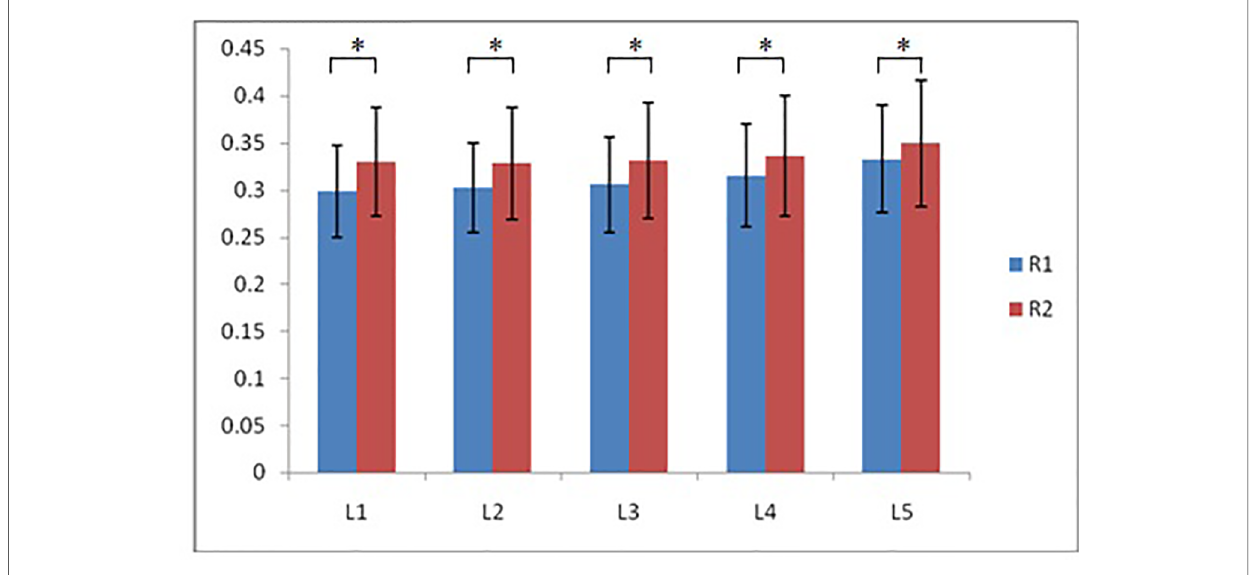
FIGURE 3 Compared with the lower endplates, the basivertebral foramen are more close to the upper endplates at all fi ve measured levels (R1: the ratio of distance between BF and upper endplate to VB height; R2: the ratio of distance between BF and lower endplate to VB height).